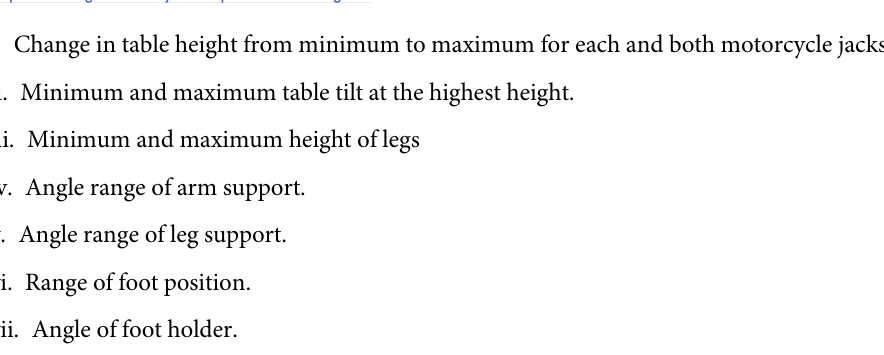
Fig 18. Addition of final component Pelvic Post Mount Pin into Leg Attachment Assembly.